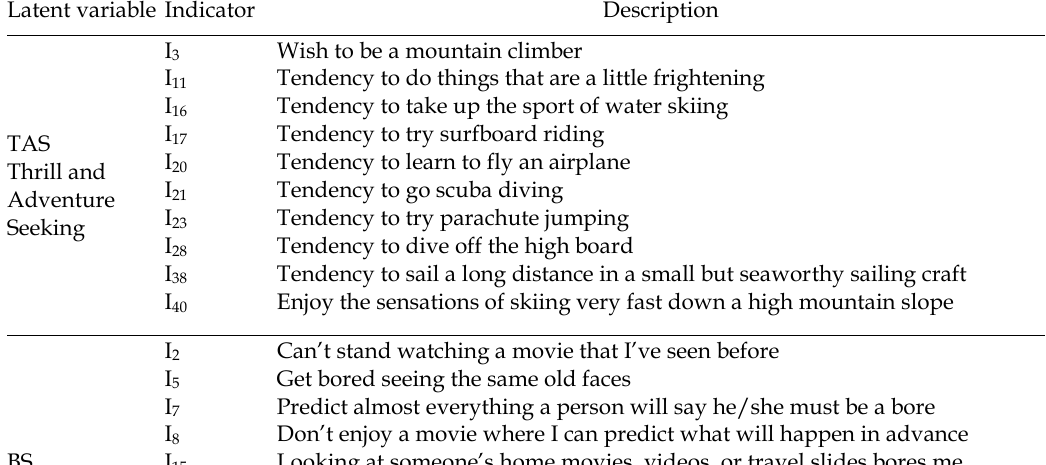
Table 1. Indicators of the latent